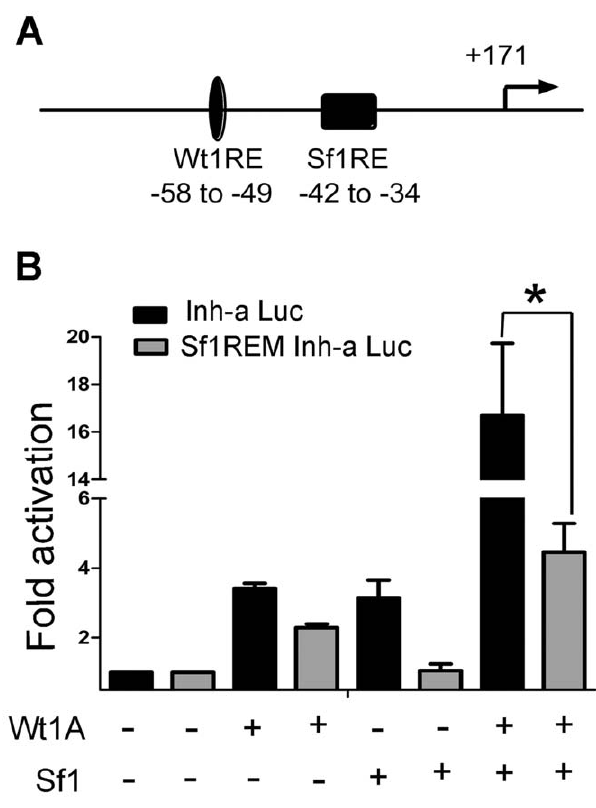
Figure 4. The inhibin- a promoter is synergistically activated by Sf1 and Wt1. A, Schematic drawing of the inhibin- a promoter region. The filled oval and box indicate the putative Wt1 and Sf1 responsive elements. B, Co-transfection of Wt1 and Sf1 significantly activated the inhibin- a promoter compared to Wt1 or Sf1 alone; luciferase activity increased about 4-fold. In contrast, when the inhibin- a promoter luciferase reporter vector with a mutated Sf1 responsive element sequence (5 9 -TCA GGG CCA-3 9 to 5 9 - TCA GTT CCA-3 9 ), Sf1REM Inh- a Luc, was co-transfected with Wt1 and Sf1, the synergistic action between Wt1 and Sf1 was completely abolished.